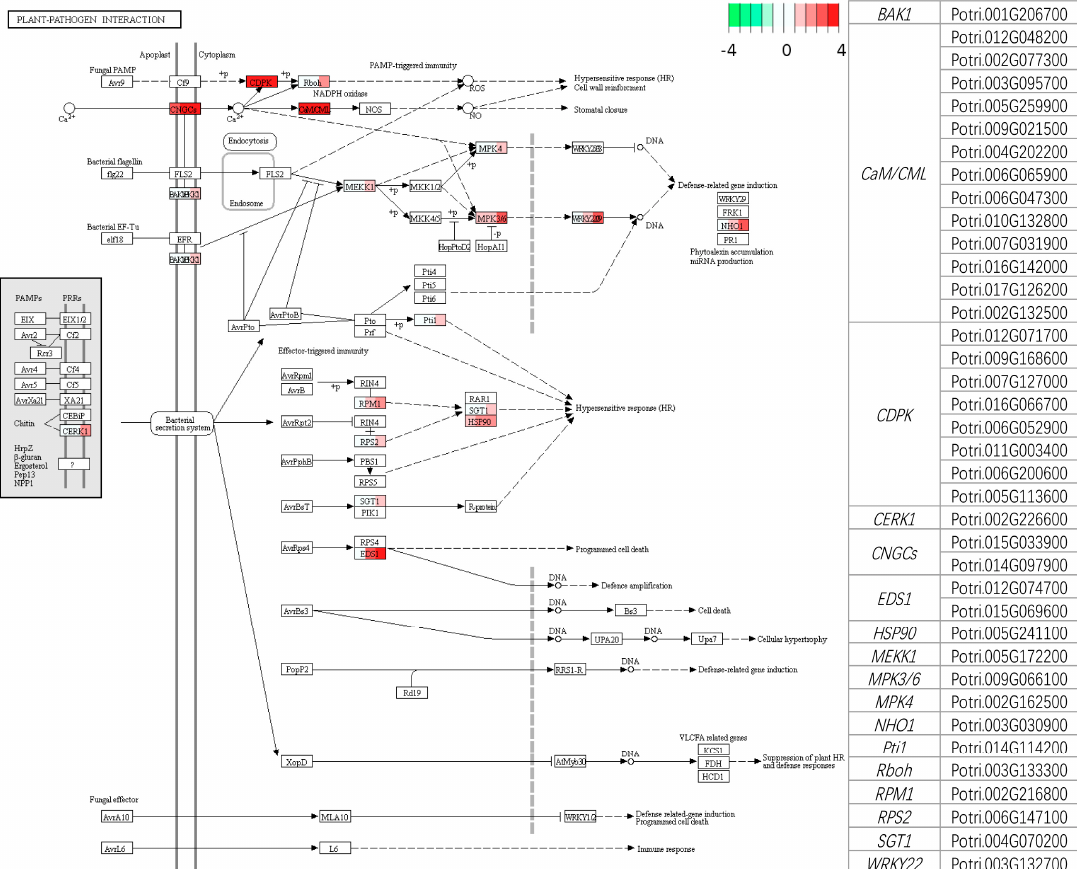
Figure 8. The gene expression pattern of some genes involved in the phenylpropanoid biosynthesis pathway of Aig. Pathway shows genes (in red) and productions in the pathway. The row of heat map represents a gene and the column represents an infection stage. The gene id and annotation are shown on the right of heat map. Histogram shows the gene expression of each gene with the value of